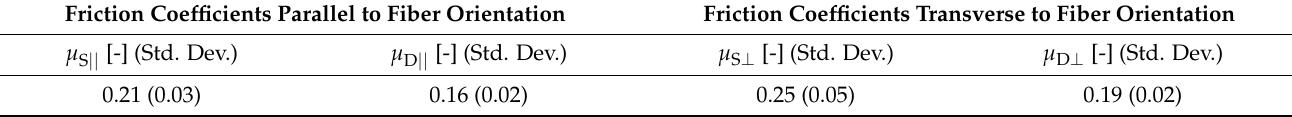
Table 4. Coefficients of friction determined between pressed PP-GF plate specimens and the stand- ard slider made from aluminum.